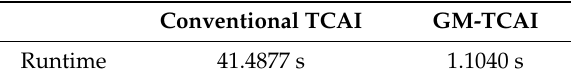
Table 3. Runtime for sparse